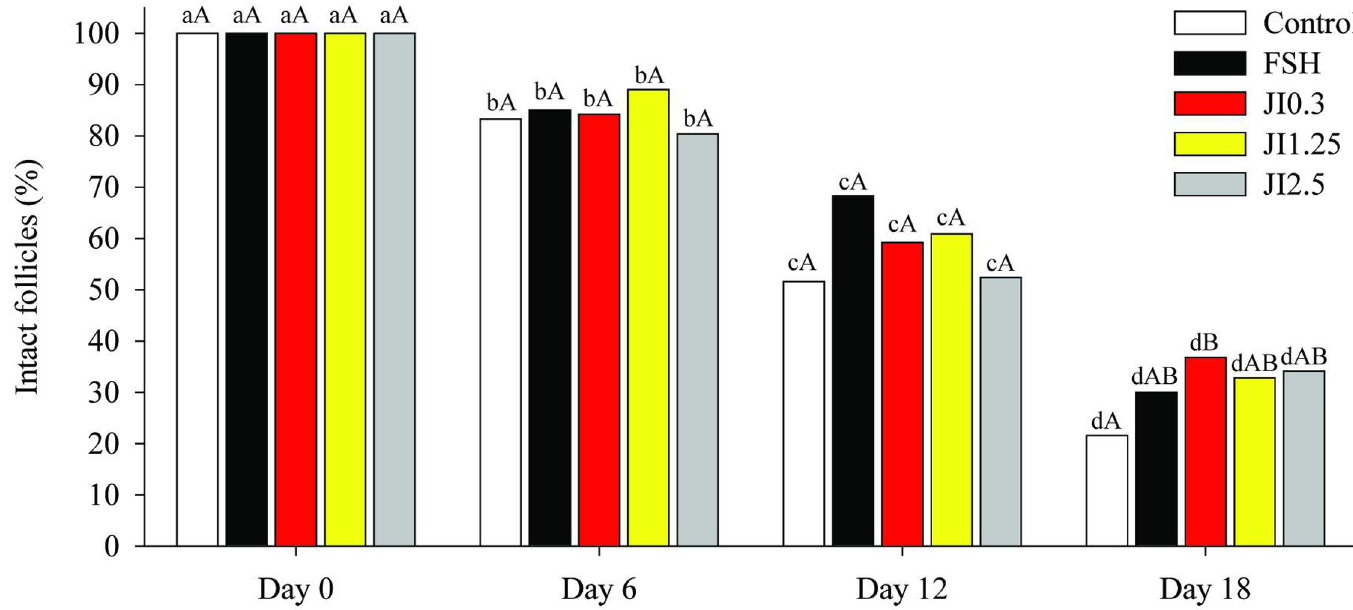
Fig 1. Percentage of morphological intact follicles at different time point (D0, D6, D12, D18) in MEM + (Control), FSH or in J . insularis 0.3, 1.25 or 2.5 mg/mL (JI0.3, JI1.25 or JI2.5 respectively). D: day, MEM + : Minimal essential medium supplemented, FSH: recombinant bovine follicle stimulating hormone, JI: J . insularis . A total of 342 secondary follicles were distributed in the different treatments (n = 6 replicates). a,b,c,d Different letters denote significant differences among time for a given treatment group (P < 0.05). A,B Different letters denote significant differences among treatment groups within the same time point (P < 0.05).